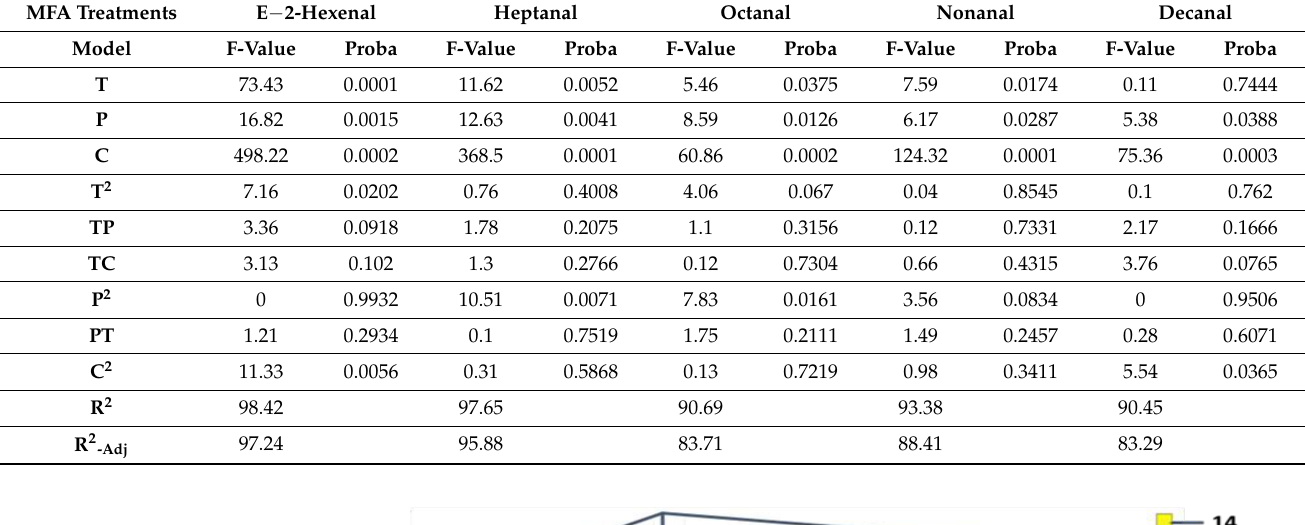
Figure 5. Standardized Pareto plots of MFA operating parameters t, P, and C on the deodorization of each volatile compound.